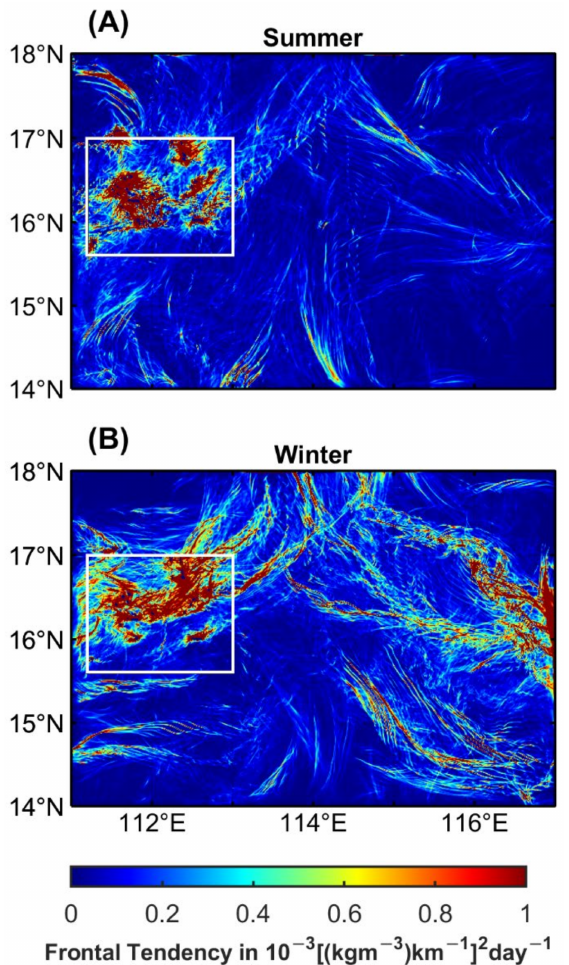
Figure 16. Averaged frontal tendency in ( A ) July and ( B ) January from 2017 to 2019, representing summer and winter, respectively. Inside the white rectangle are the Xisha Islands. We note that the unit of the color bar is 10 − 3 ((kg m − 3 ) km − 1 ) 2 day − 1